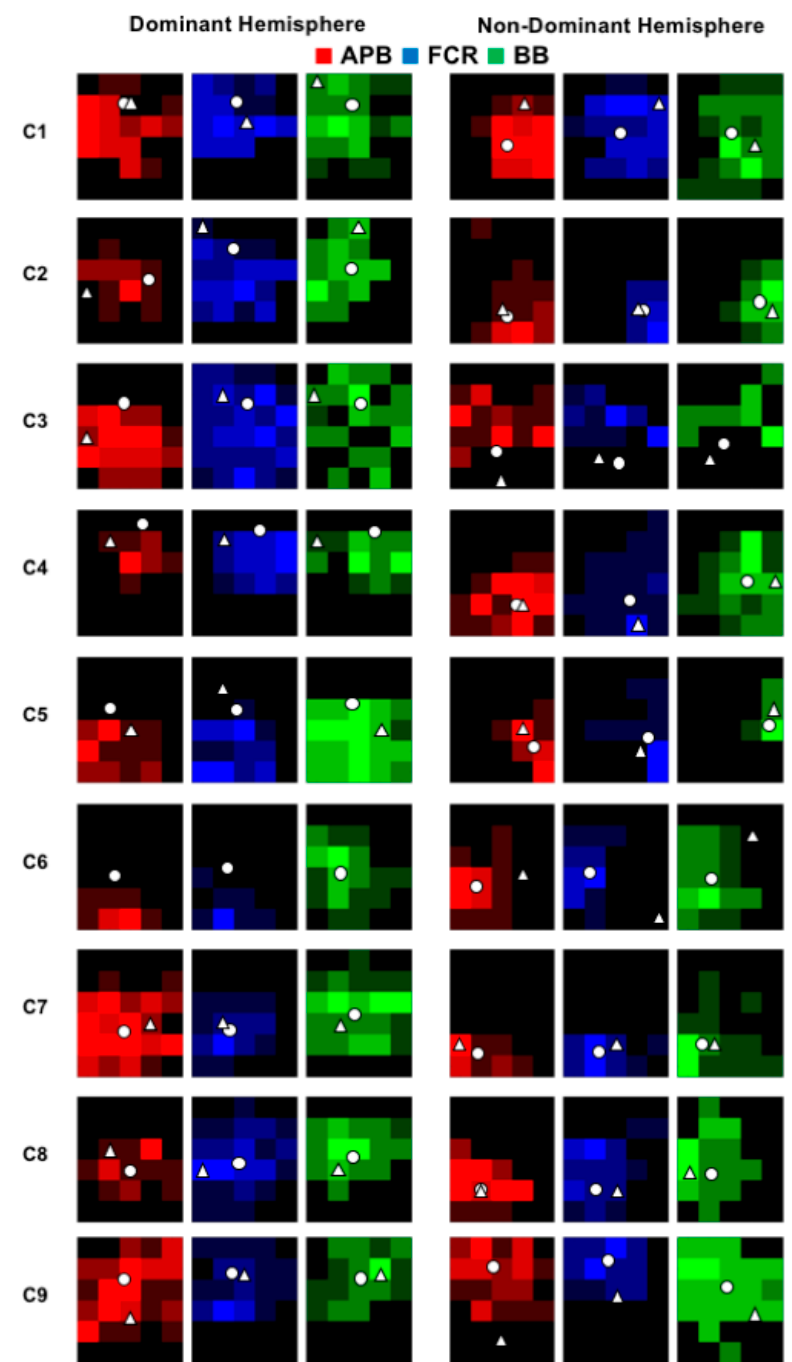
Figure 2. Individual cortical territory plots for each hemisphere and muscle for the control group. Pixel maps represent the size of the cortical territories and the white circle indicates the location of the center of gravity (CoG).